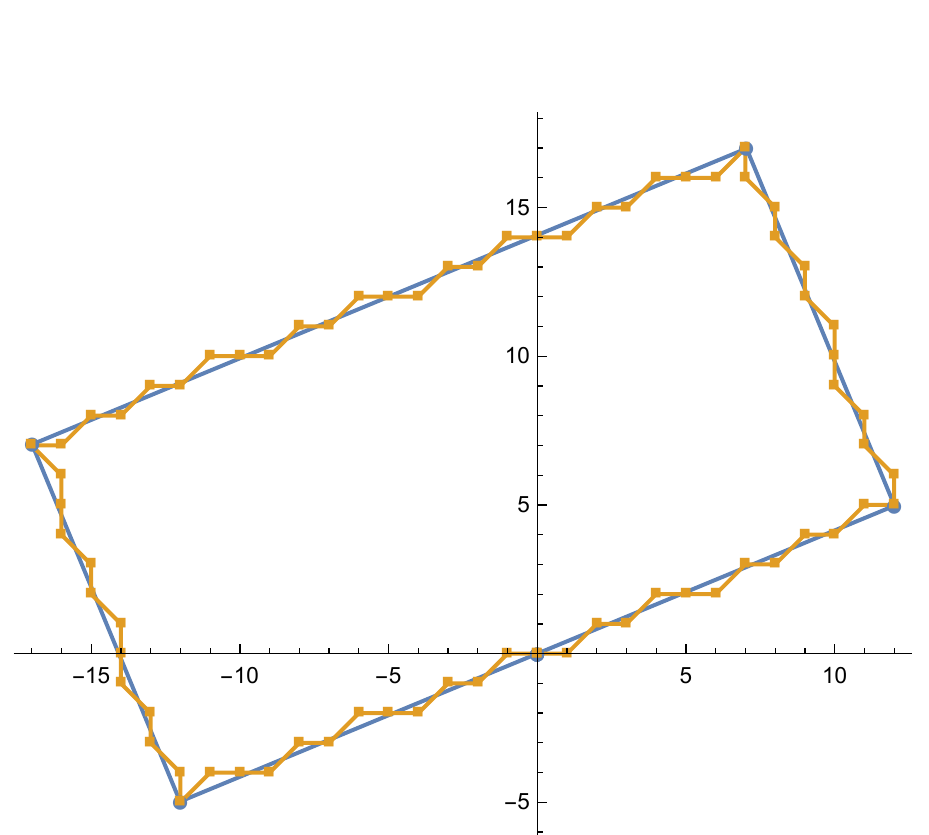
Figure 3. Lattice approximation to third operator in (cid:12)gure 2b, rotated by (cid:25)= 8.